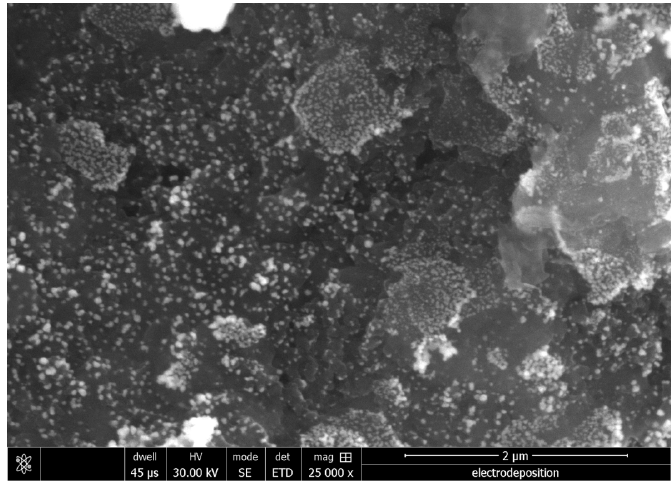
Figure 2. SEM image of rGO-Au nano /GCE.